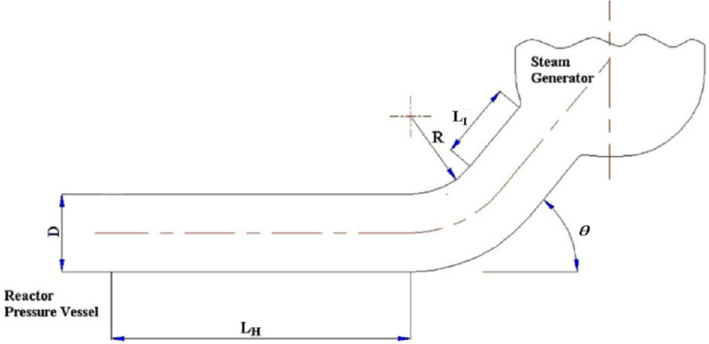
Figure 6. Typical hot leg geometry (Deendarlianto et al. [8]). Table 4. Summary of the experimental investigations on the CCFL in the model of a PWR hot leg.